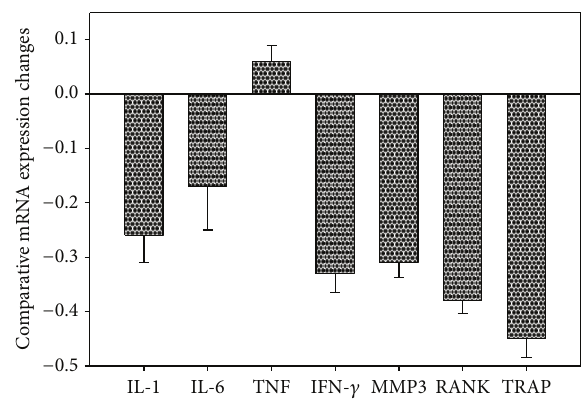
Figure 6: Gene expression profiles of the arthritic joint tissues following OPG gene transfer. The data are expressed as percentage changes of the comparative gene copies against readings from the LacZ-control gene transduced tissues. No mRNA expression change is expressed as